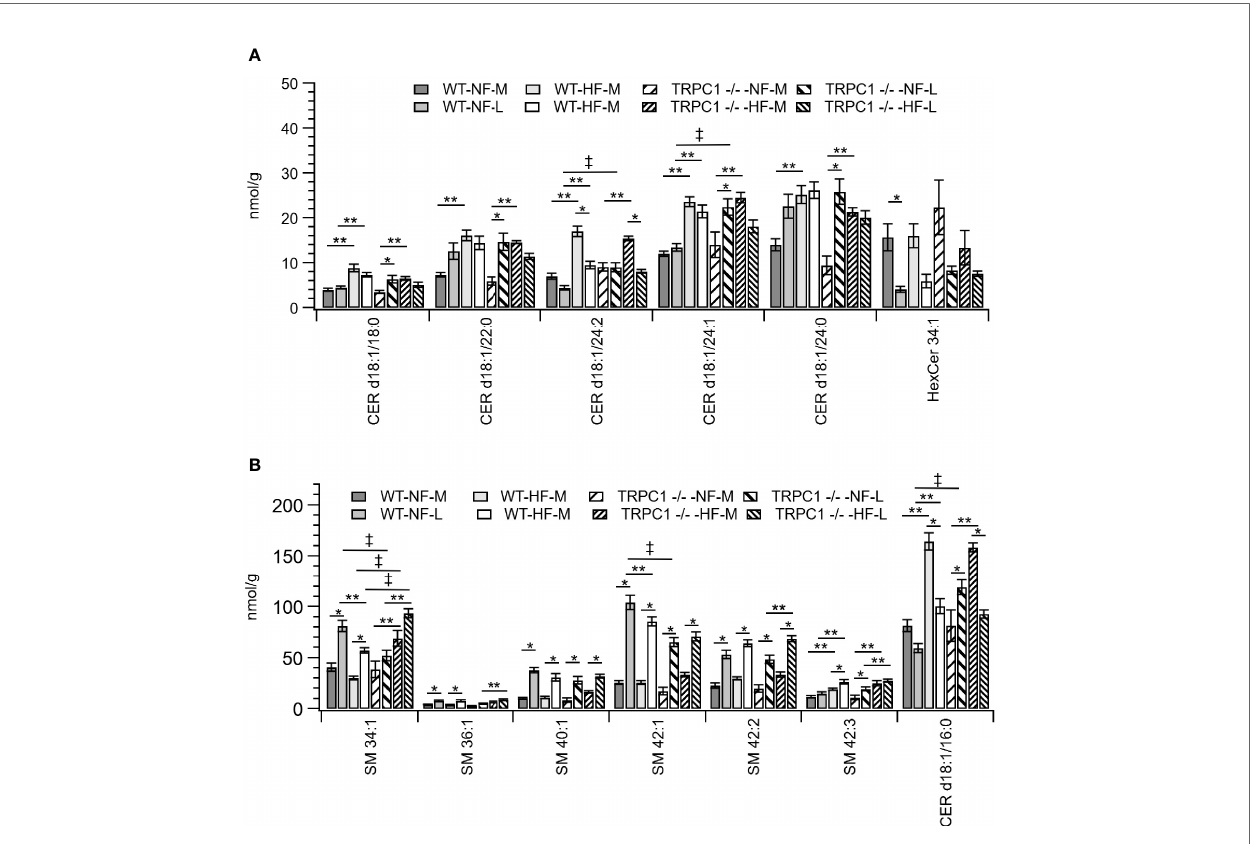
FIGURE 5 | Placental sphingolipid concentration by species. (A) Cer, and (B) SM species. Data are shown as mean ± sem (n = 8, except for HF-TRPC1-M where n = 4). Symbols indicate differences with p<0.05 base upon one-way ANOVA with Tukey ’ s HRD post hoc test and application of a 0.05 false discovery rate for gestational age (*), diet (**), and genotype ( ‡ ). P-values are available in Supplemental Materials . WT, wild-type; TRPC1 -/-, TRPC1 knock-out; NF, normal fat diet; HF, high-fat diet; M, mid-gestation; L, late